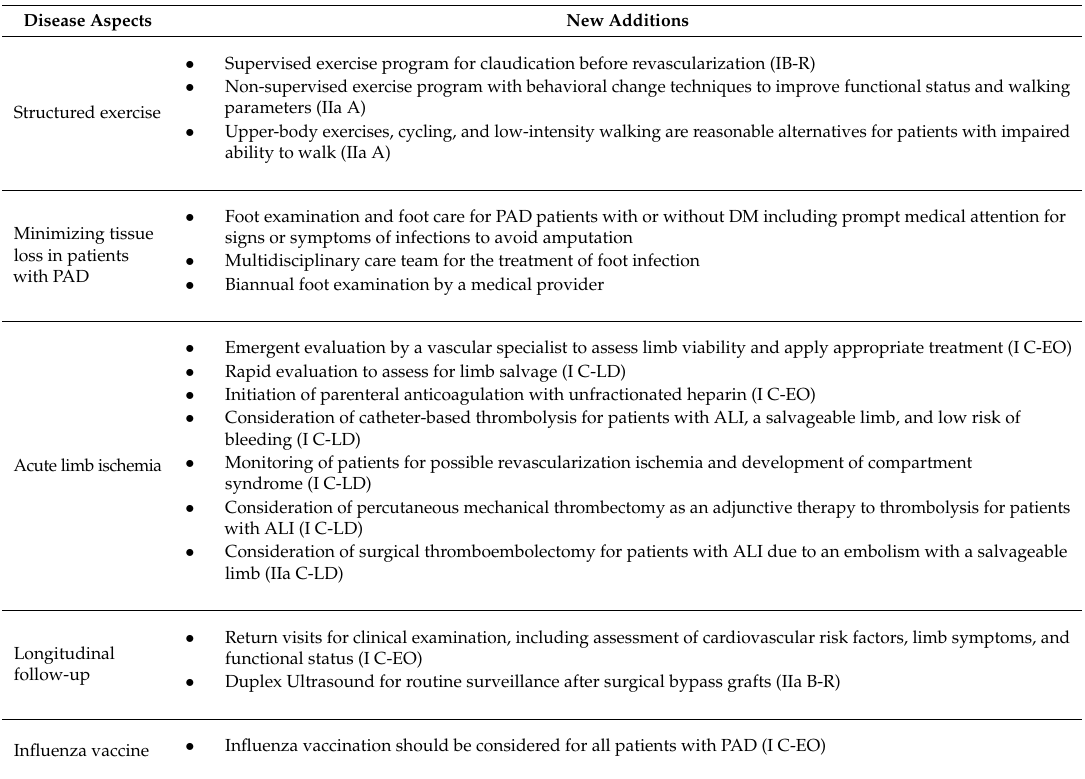
Table 3. New additions in 2016 guidelines for